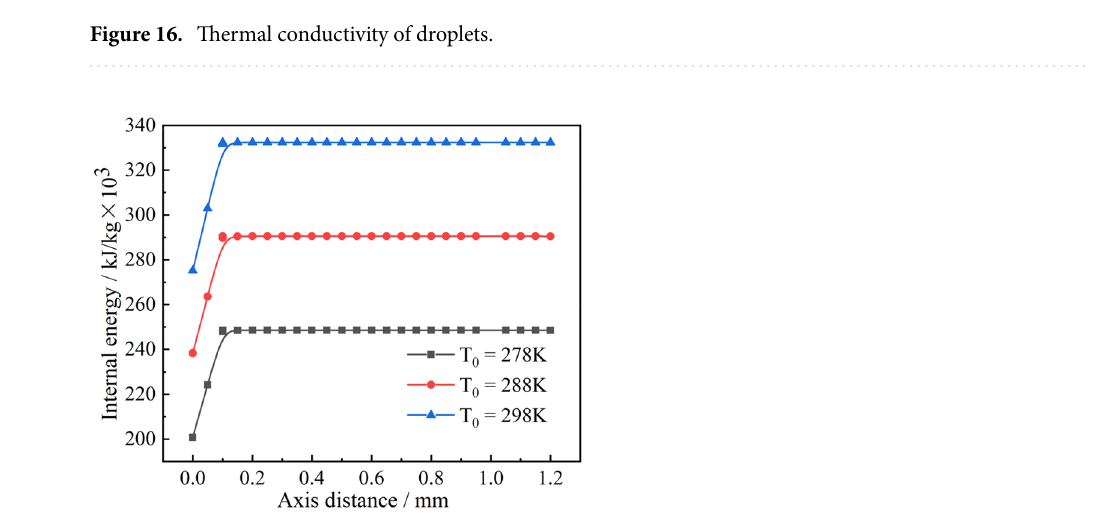
Figure 17. Droplet internal